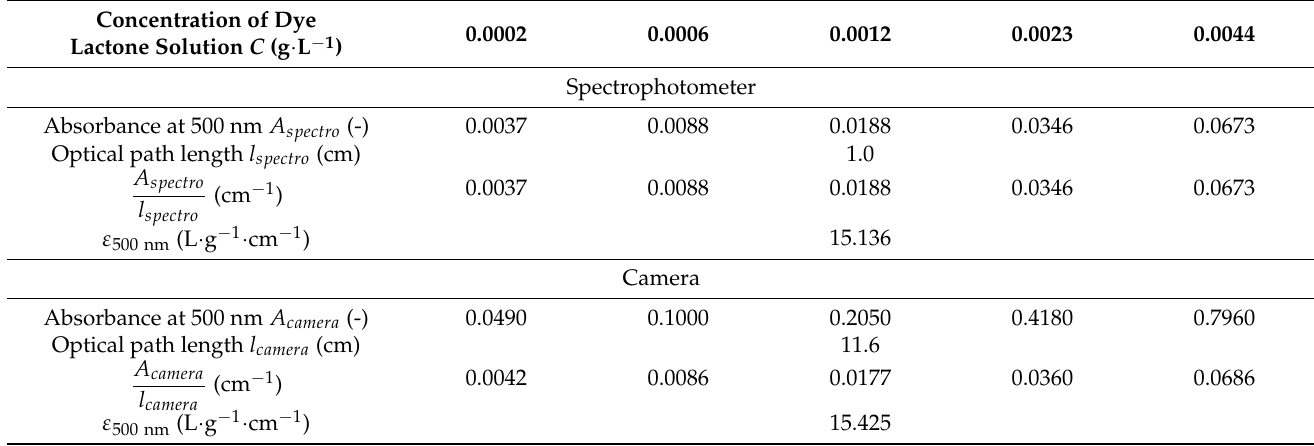
Table 3. Spectrophotometer and camera-deduced optical parameters for standard solutions of Rose Bengal lactone.